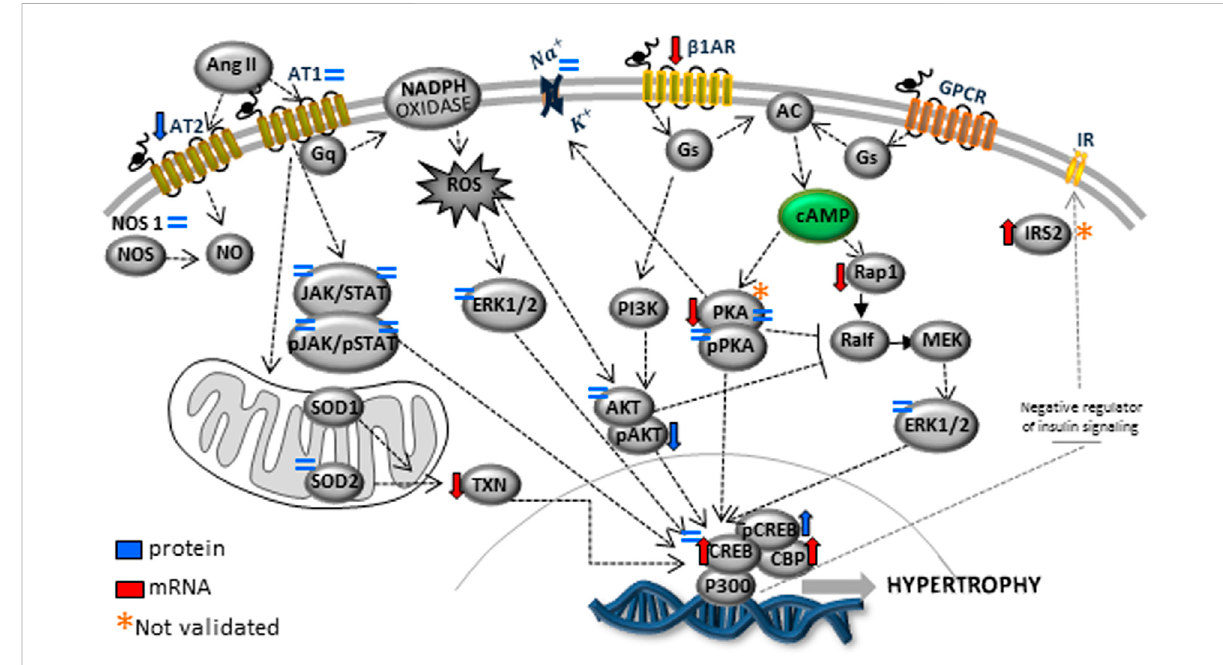
FIGURE 9 The picture depicted a schematic representation of the cyclic AMP and associated pathways investigated and biological response disorders in LV from 62nd weeks of age male rats from maternal restricted-protein